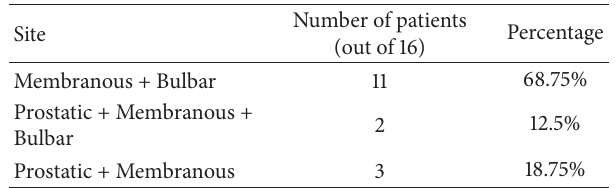
Table 1: Site of